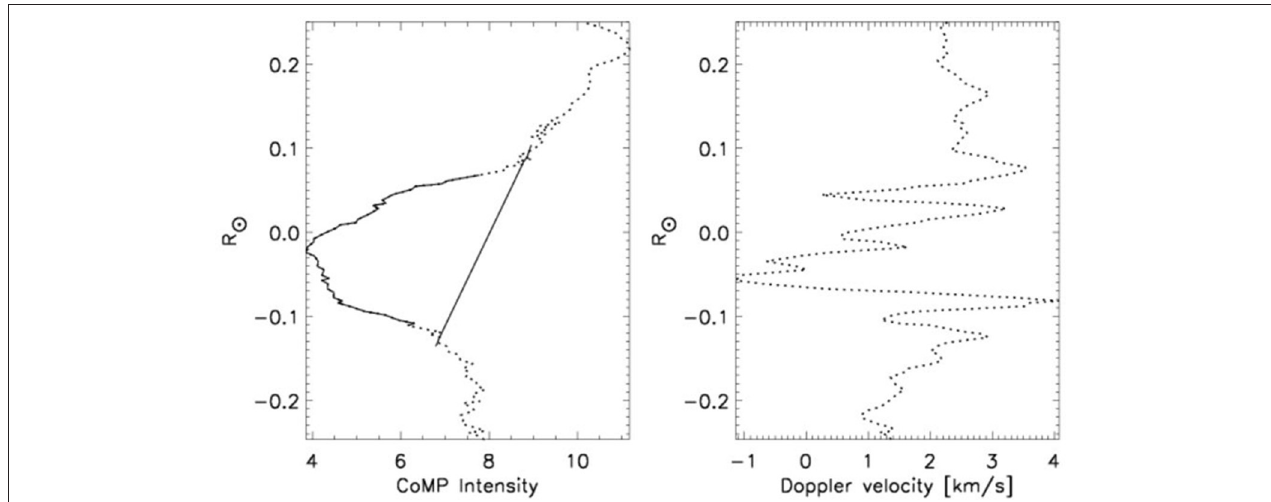
FIGURE 2 | Left: CoMP intensity profile across polar-angle cuts at the height equal to the cavity center height for the 20 March 2012 cavity. Solid line shows 3 σ depletion under the fitted straight line. Right: Observed Doppler velocity profile.